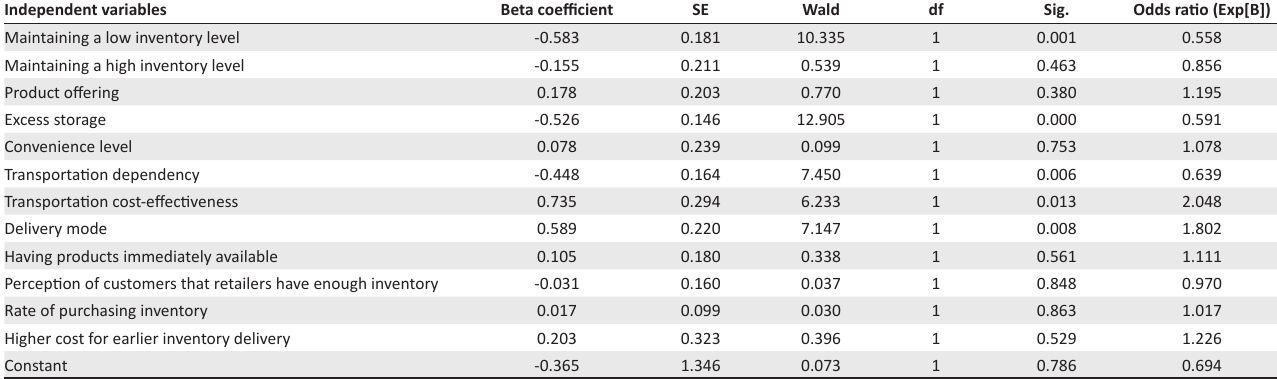
TABLE 5: Independent variables in the equation for the binary logistic regression model with the dependent variable age. Independent variables